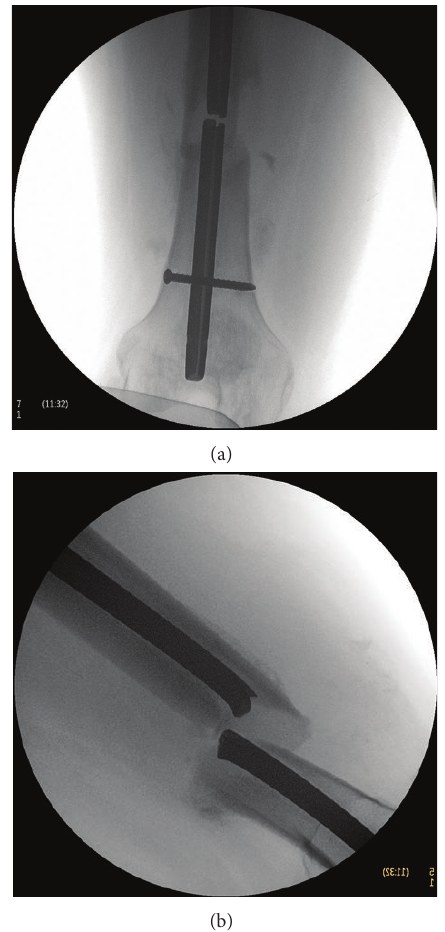
Figure 1: The radiographs show displaced fracture at distal 1/3 of the right femur with a retained broken AO femoral nail in (a) AP and (b) lateral view.